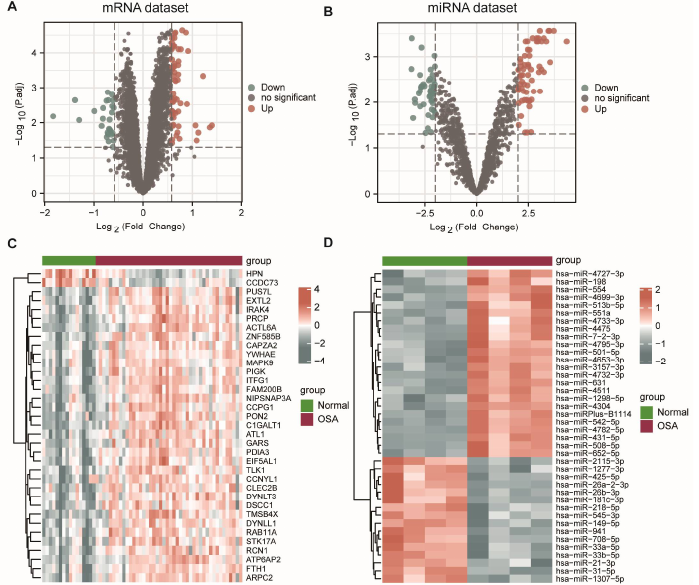
Figure 2. Volcano plots and heatmap plots of DEmRNAs and DEmiRNAs. ( A ) Volcano plot of DEmRNAs (126 controls vs. 119 OSA patients). The threshold set as the adj p -value < 0.05 and |log2FC| > 0.58. ( B ) Volcano plot of DEmiRNAs (4 controls vs. 4 OSA patients). The threshold set as the adj p -value < 0.05 and |log2FC| > 2. Green nodes indicate differences in OSA differentially downregulated, red nodes indicate mRNAs differentially upregulated in OSA. ( C ) Heatmap of the top 35 DEmRNAs with lowest adj p -value. ( D ) Heatmap of the top 35 DEmiRNAs with lowest adj p -value. Red means high expression, and blue means low expression. Each column represents a sample, and each row represents a